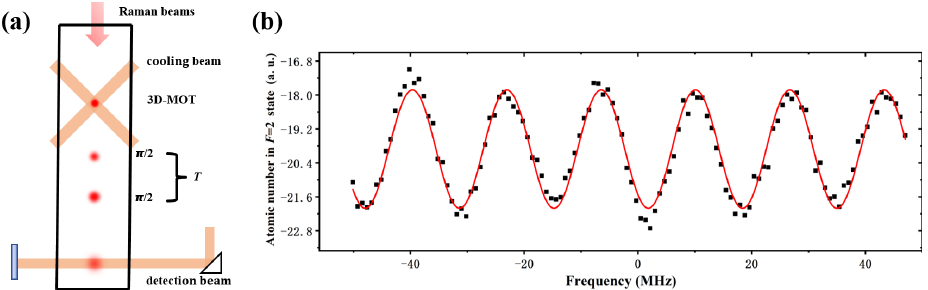
Figure 4. The diagram of the experimental setup and atomic interference fringes: ( a ) the schematic diagram of the experimental apparatus; ( b ) the obtained atom interference fringes ( T = 60 ms). The black square dots represent the experimental data, and the red curve denotes the fitted line with a sine function.